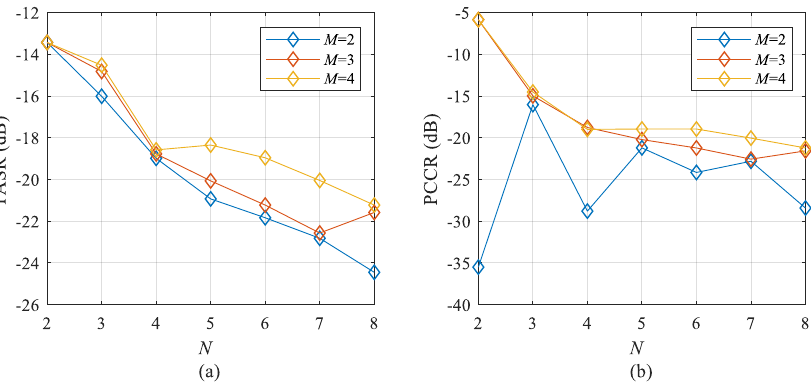
Figure 11. The PASR and PCCR of the waveform obtained by the propoesd algorithm under dif- ferent M and N ( a ) PASR, ( b )